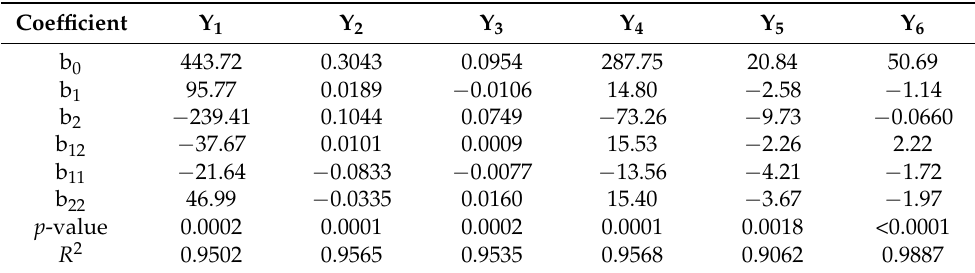
Table 2. The experimental equations created for various hydrogel patch responses.